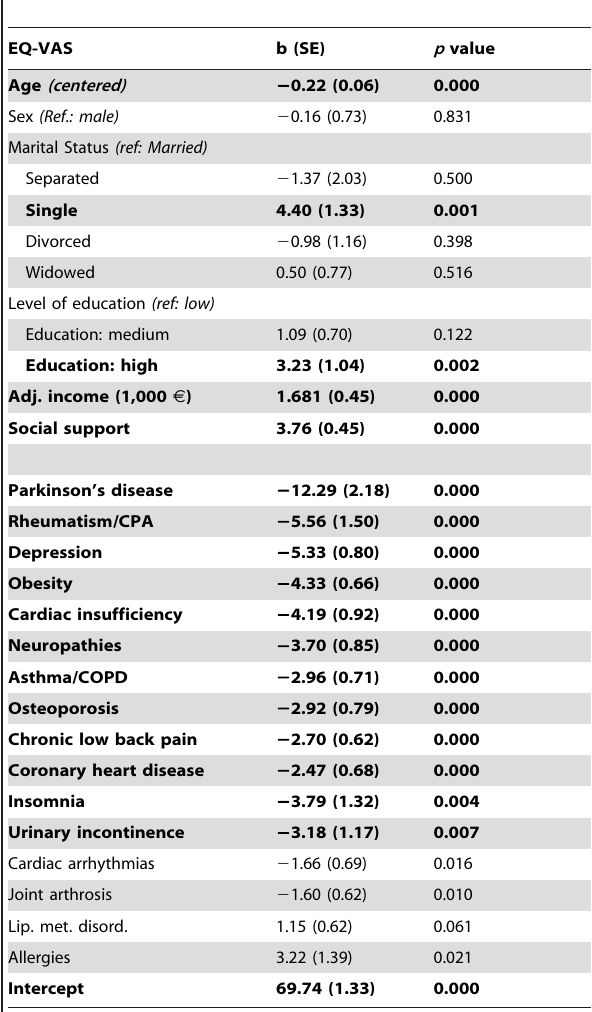
Table 5. Multiple linear regression model of the effect of individual conditions on overall HRQL measured by